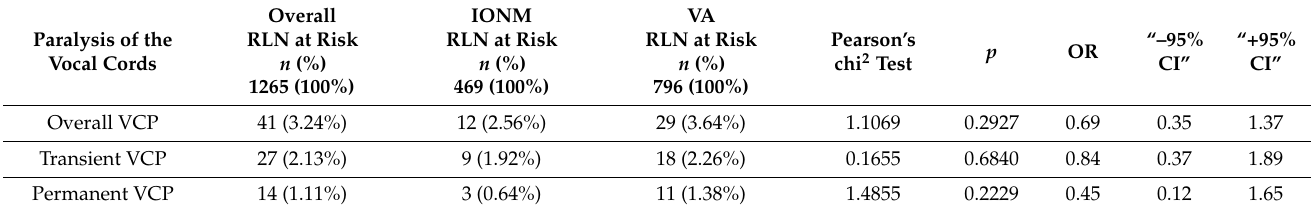
Table 3. The total, transient and permanent number of occurrences of vocal fold paralysis in the group of patients operated on with IONM vs.